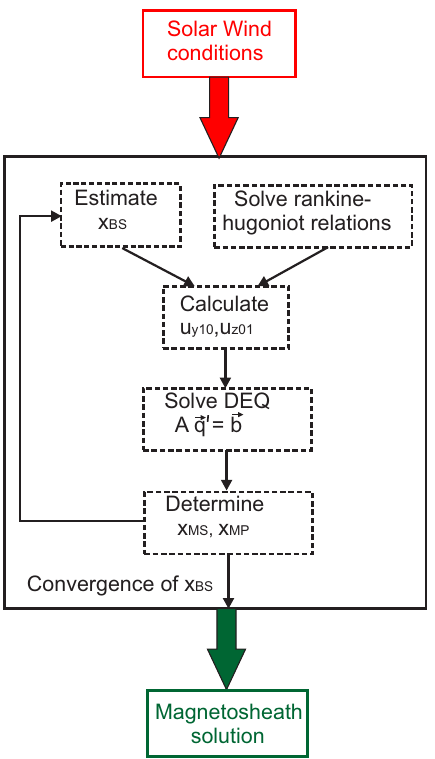
Figure 1. Scheme of the forward magnetosheath model presented in Nabert et al. (2013). The solar wind conditions are the input to the model. First, the bow-shock distance is initially estimated. Then, the Rankine–Hugoniot relations are solved and determine the post- shock values, which are used as boundary conditions for the sys- tem of differential equations (DEQ). Solving this system leads to a new estimate of bow-shock distance. After some iterations, the bow-shock distance converges and the magnetosheath solution is